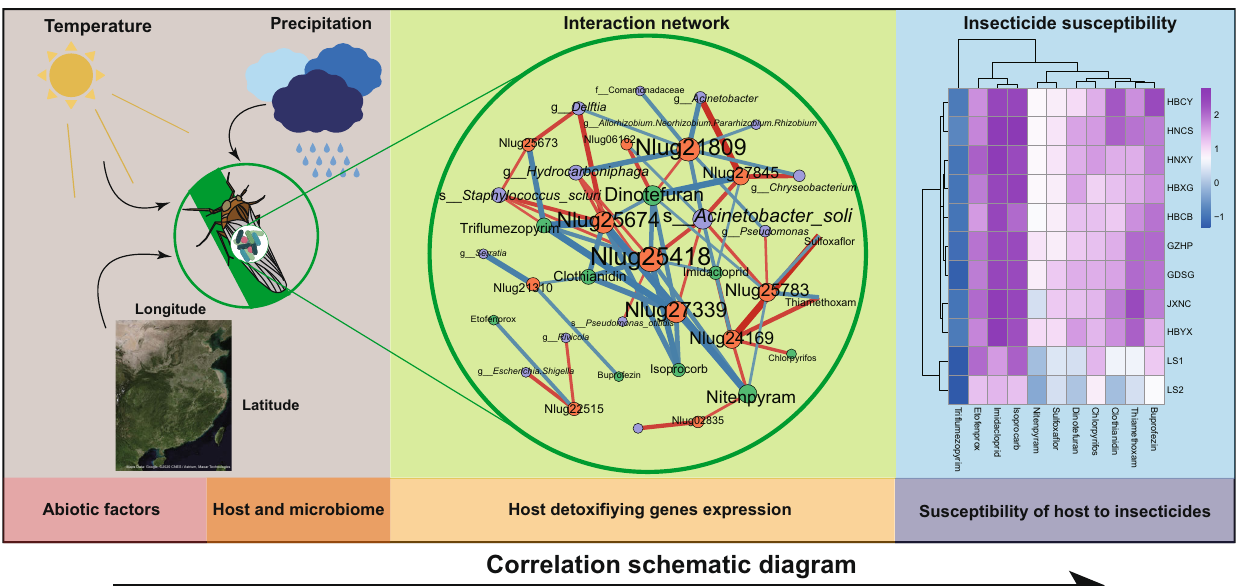
Fig. 6 The diagram of environmental abiotic factors associated with microbiome variation correlated with detoxifying gene expression led to the difference in insecticide susceptibility among fi eld Nilaparvata lugens strains. The map was downloaded from Google